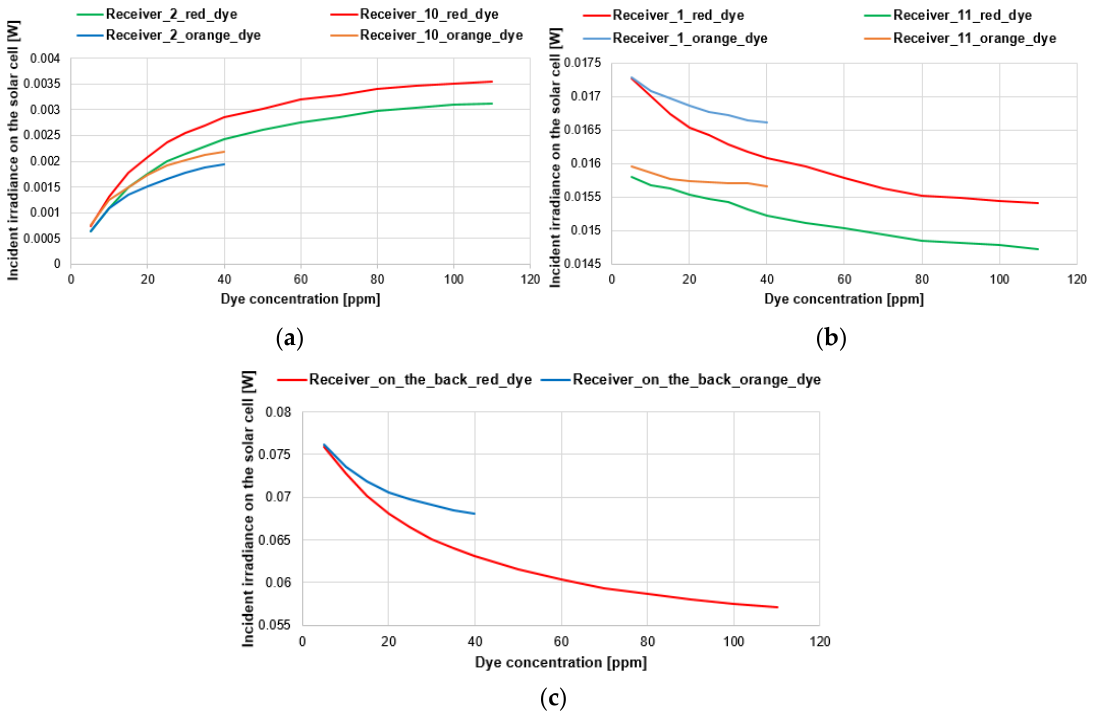
Figure 7. A comparison of the diffuse incident irradiance on the solar cells in LSC PV design Configuration 2—see Table 1—under exposure to STC irradiance (1000 W/m 2 , 50% direct and 50% diffuse) for the case of the orange and the red dyes: ( a ) the solar cells surface in between the lightguides, inner sides; ( b ) the solar cell surface in between the lightguides, outer sides; ( c ) the solar cell surface at the back.